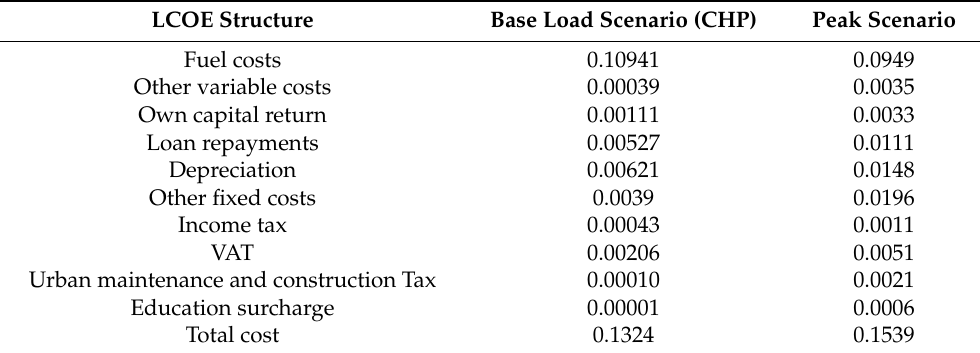
Table 9. The levelized cost of electricity (LCOE) of centralized NGPG in base and peak scenarios (Unit: